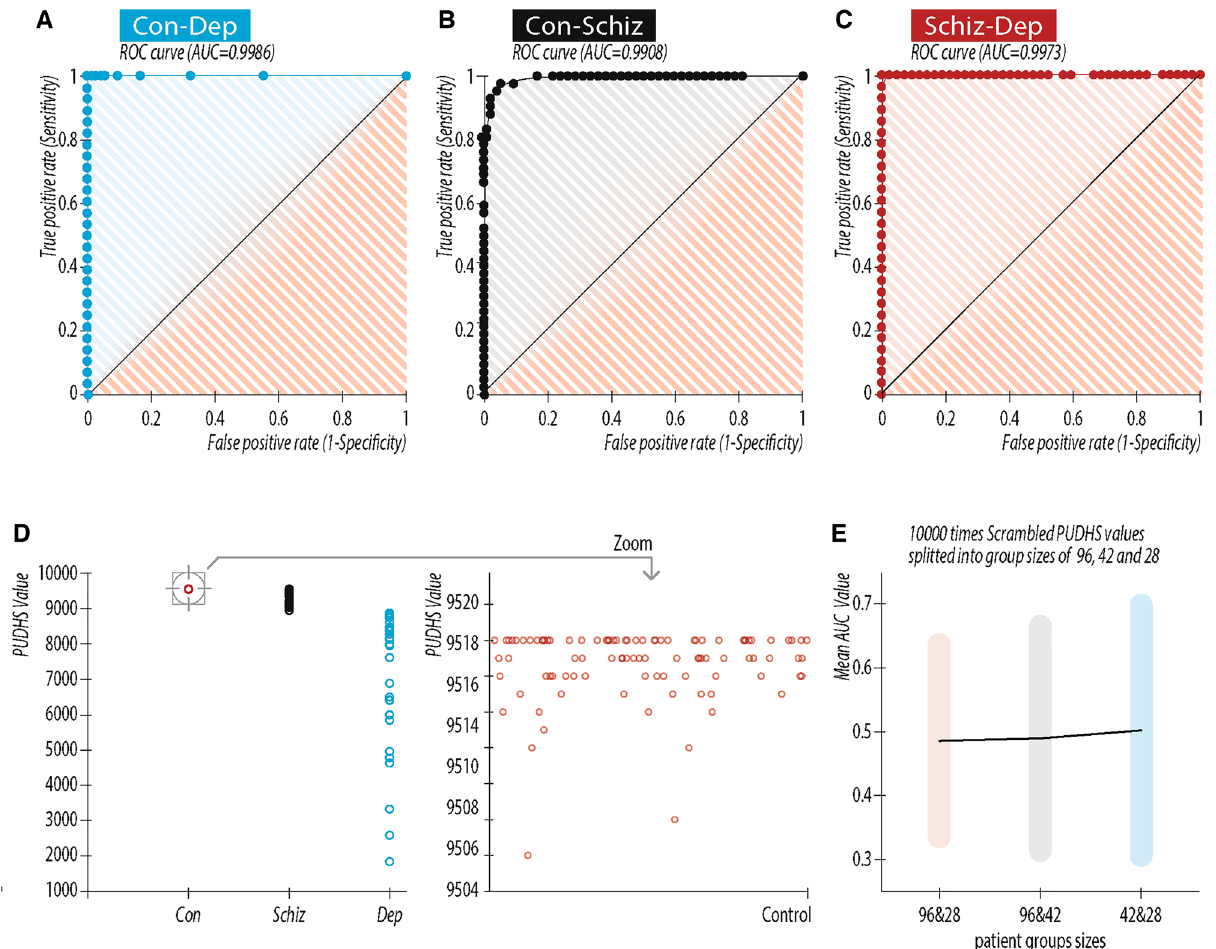
Figure 2. Accuracy of the EEG based personal universal DH signatures (PUDHSs) in differentiating control subjects from patients with schizophrenia and depression with artefact removal. Artefacts in the EEG caused by eye blinks, muscle activation, or other movement artefacts were removed for each patient’s EEG as described in the methods. Accuracy depicted as receiver operating characteristic (ROC) curves for ( A ) control vs. depression, AUC = 0.9986, p < 0.0001. ( B ) Control vs. schizophrenia 0.9908, p < 0.0001. ( C ) Schizophrenia vs. depression AUC = 0.9973, p < 0.0001. ( D ) Scatter plot of PUDHS values obtained from the control, schizophrenia, and depression patient groups. each range of PUDHS values belong exclusively to each clinical condition. each range of PUDHS values belong exclusively to each clinical condition. The insert shows a zoom-in of all control patients PUDHS values for better visuality. ( E ) Mean ± 3*std of AUC values obtained from ROC curves by 10,000 random grouping of patients into 3 groups with the size of 96, 42 and 28